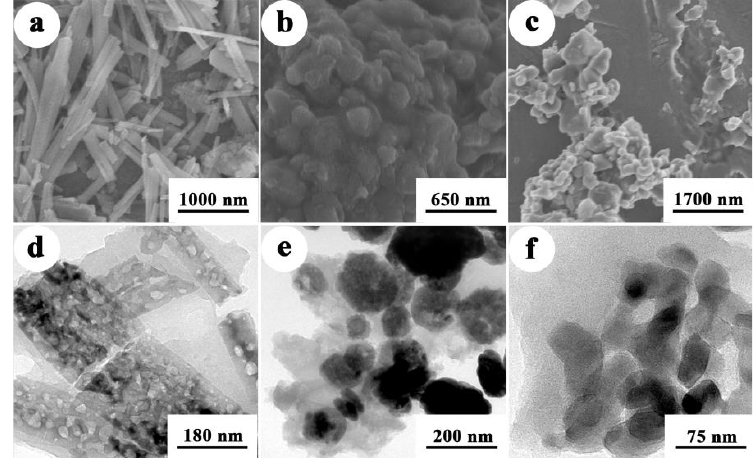
Figure 4. SEM images of the C@Fe 3 O 4 composites ( a ) nanorod, ( b ) nanodisk, and ( c ) nanoparticle; TEM images of the C@Fe 3 O 4 composites ( d ) nanorod, ( e ) nanodisk, and ( f ) nanoparticle.